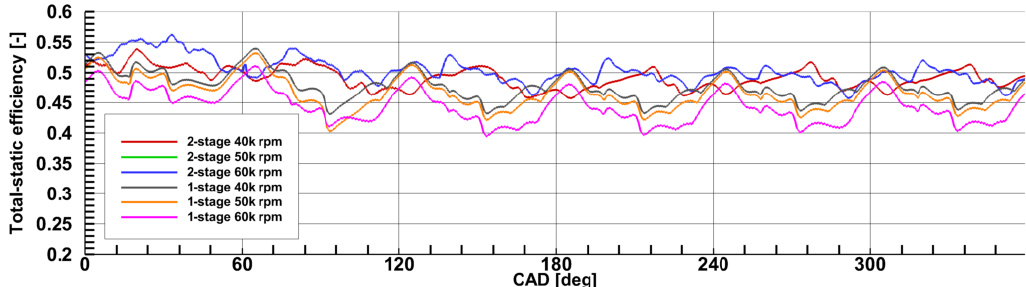
Figure 18. The total-static efficiency of the two-stage exhaust system and single-stage exhaust system for three different turbine speeds during the 3rd revolution of the crankshaft.